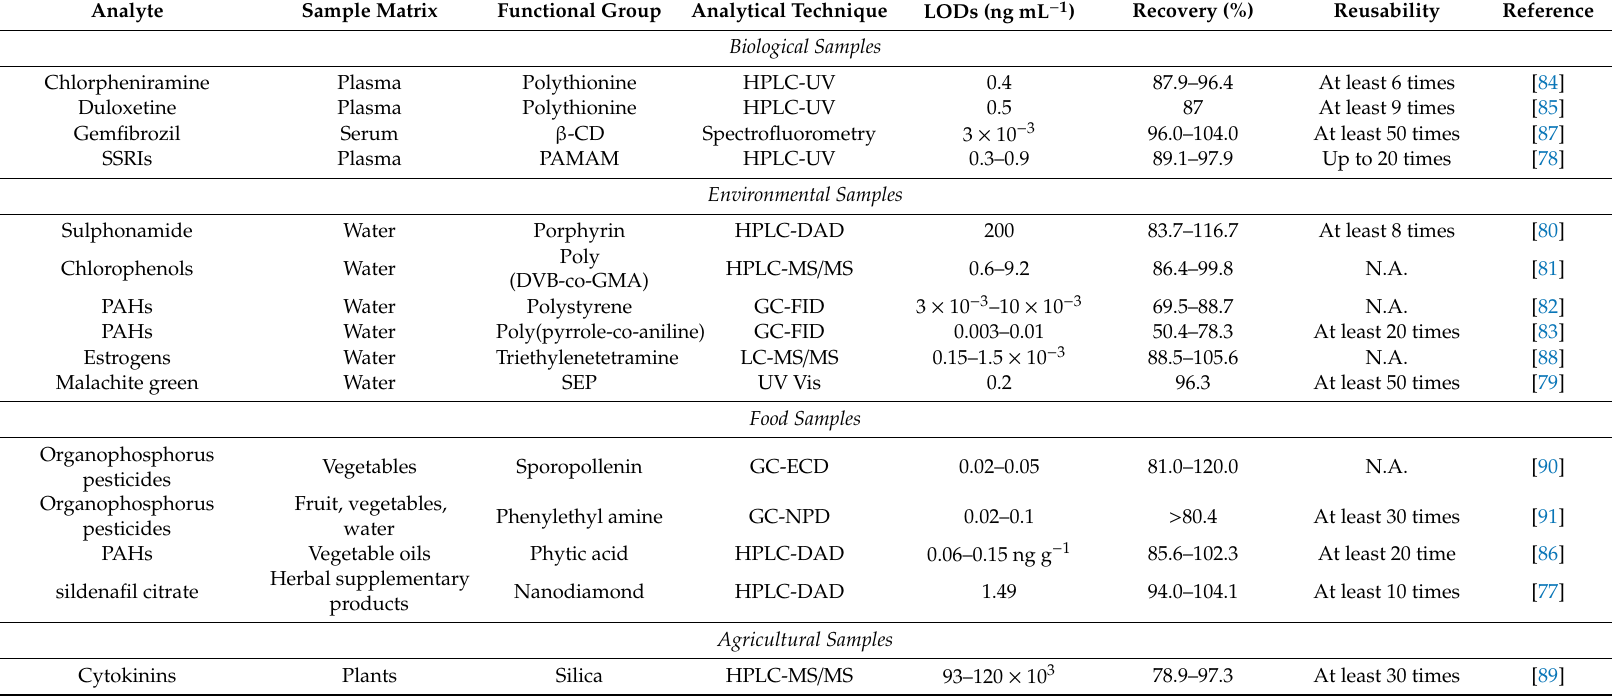
Table 2. Application of functionalized GO / Fe 3 O 4 nanocomposites for the MSPE of organic